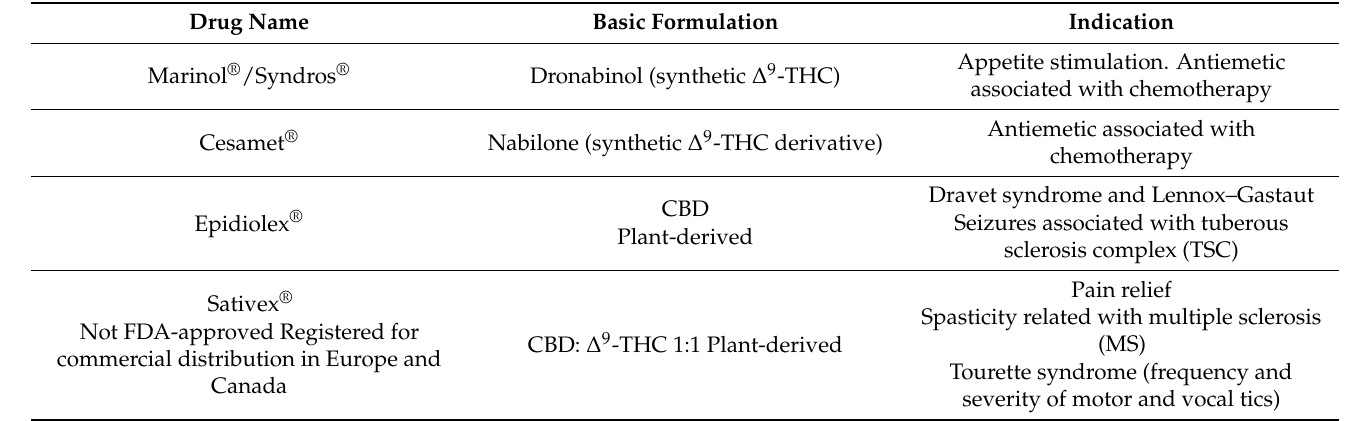
Table 1. FDA-approved cannabis-based pharmaceutical-grade drugs developed and marketed to 2023